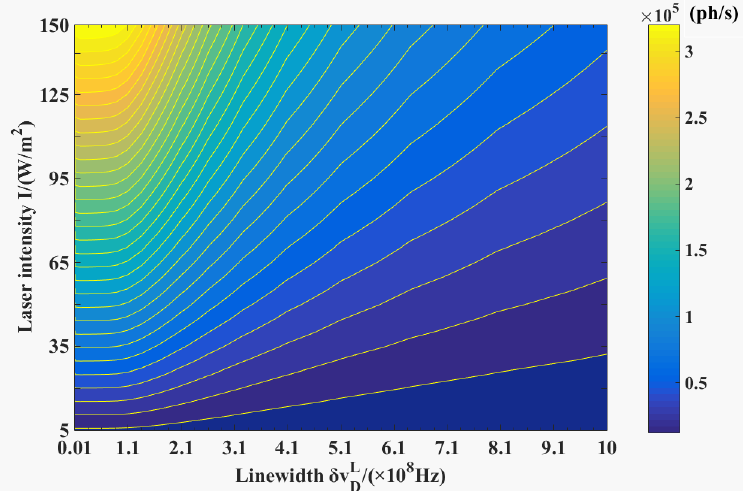
Figure 8. Average spontaneous emission rates for laser linewidth from 3 to 10 3 MHz and laser intensity I = 5 − 150 W/m 2